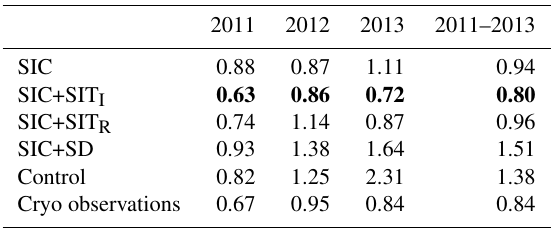
Table 2. The March–April averaged RMSE values of the five ex- periments compared to the IceBridge aerial SIT observations. Bold values represent the model with the lowest RMSE values for that year.